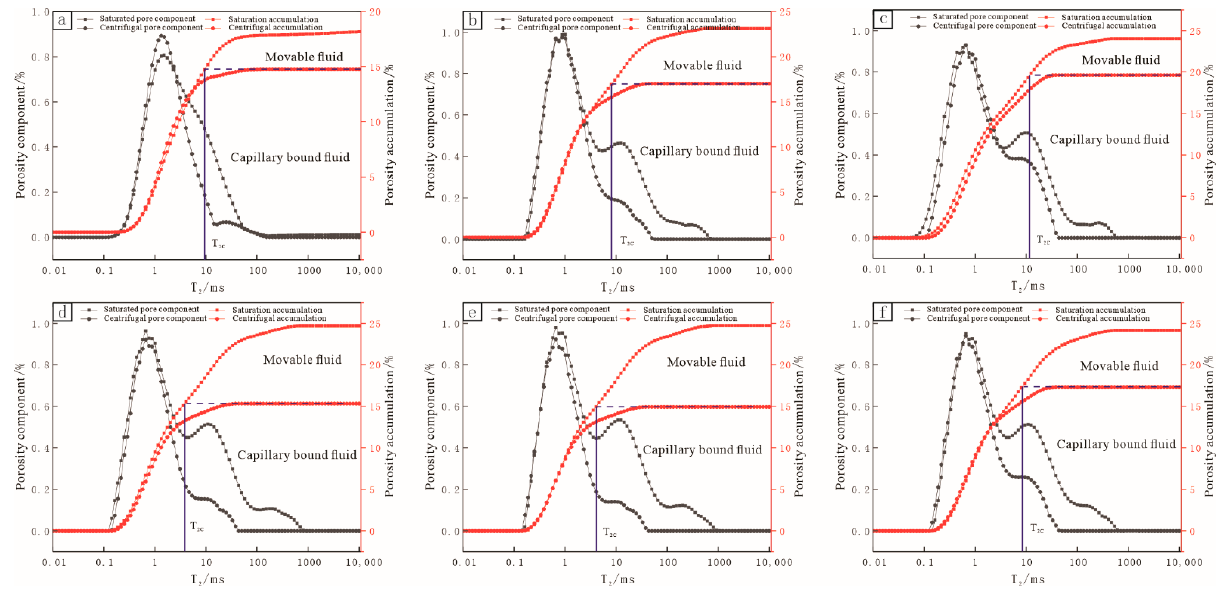
Figure 9. ( a – f ) Porosity component and cumulative porosity before and after centrifugation.